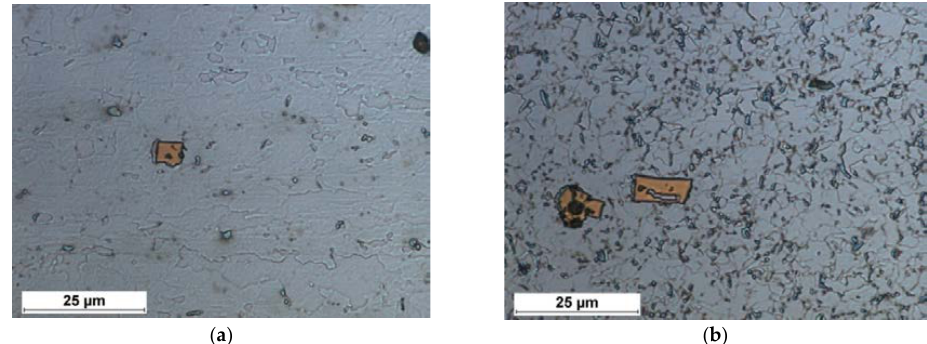
Figure 10. Nitride precipitates in the hybrid welded joint (laser-MAG) made of S700MC steel. ( a ) base material, ( b ) HAZ.